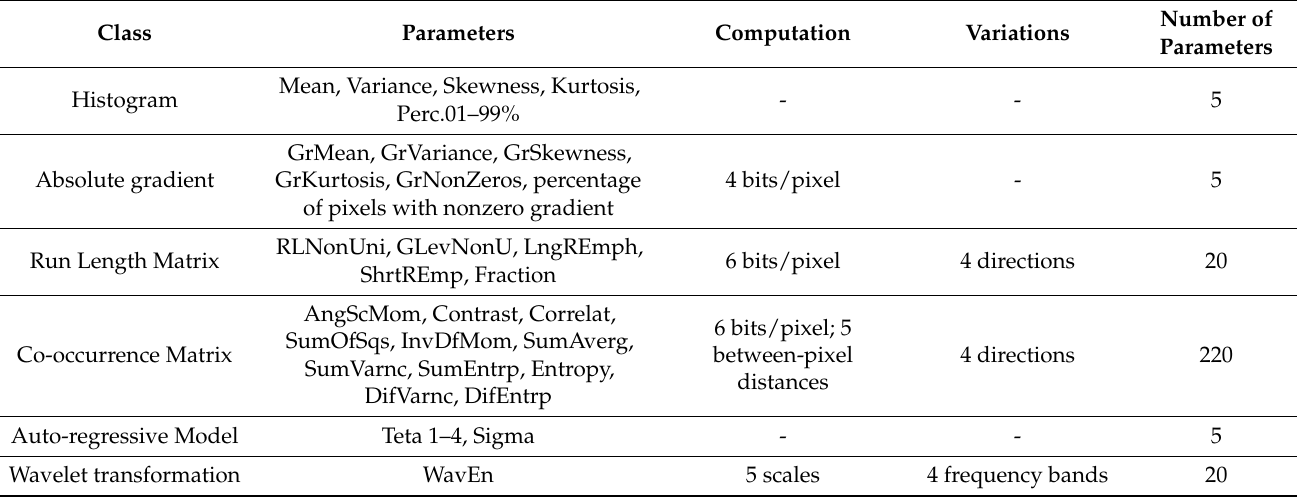
Table 1. Texture